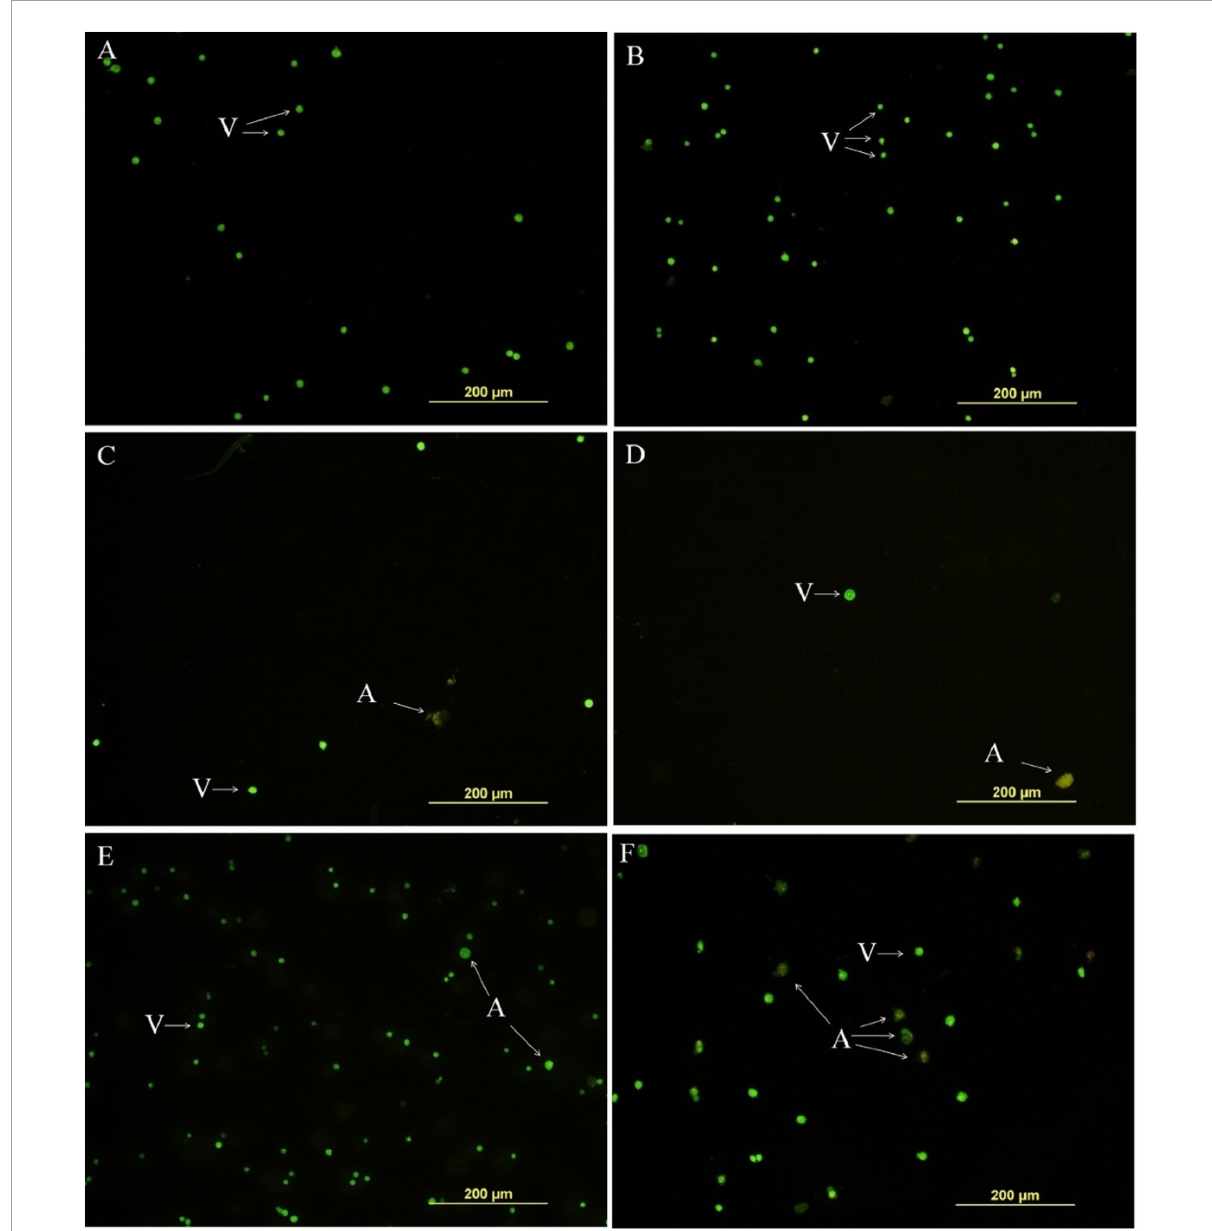
FIGURE13 Euphol isolated from the latex of E. tirucalli inhibited total number of tumor cell K-562 cells after treatment (12 h). (A) Control cells incubated with RPMI only; (B) control cells incubated with DMSO (0.4%); (C) euphol treatment (23.4 µ M); (D) euphol treatment (46.9 µ M); (E) imatinib (0.5 µ M); and (F) doxorubicin (0.085 µ M). v, viable cells; a, apoptotic cells (Cruz et al.,